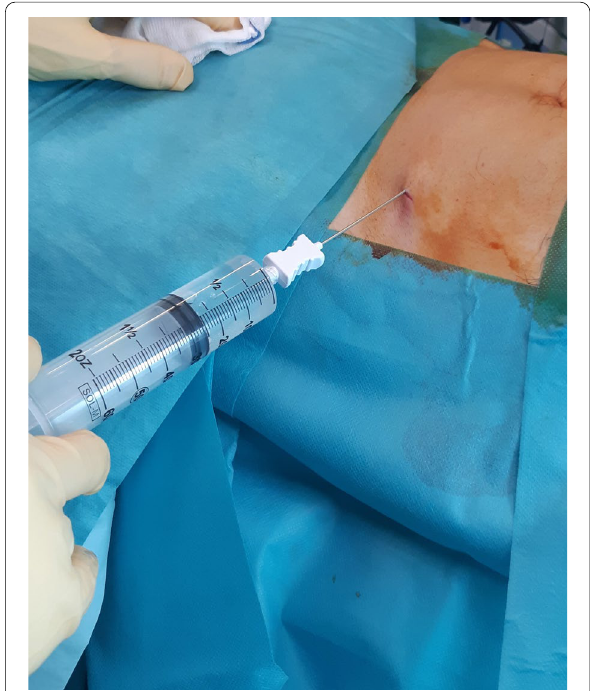
Fig. 1 Saline solution mixed with ropivacaine and adrenaline (Klein solution) percutaneously injected into the subcutaneous tissue of the abdomen to expand the spaces inside of the adipose tissue and to allow successive lipoaspiration